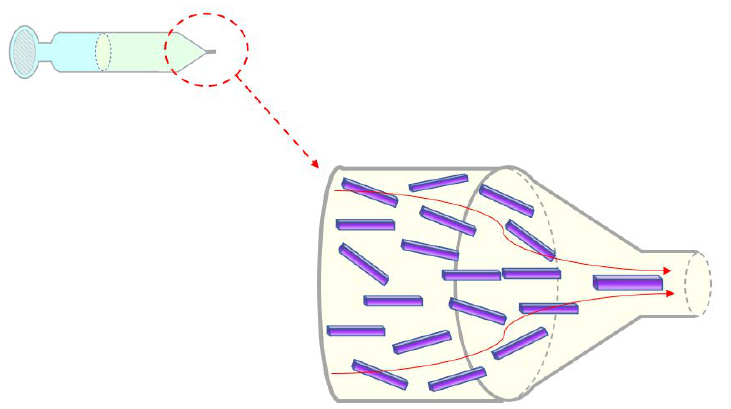
Figure 1. Microrods flow and alignment through the extruder-like geometry are affected by hydrogel matrix flow, length, and density of microrods.